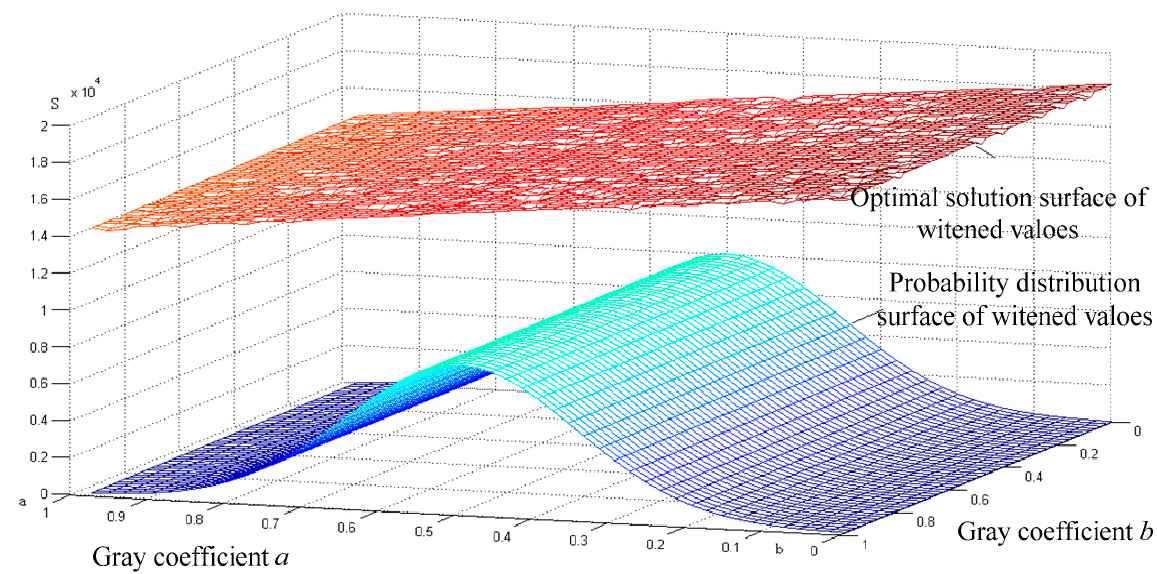
Figure 3. Economic operation flowchart for the grey multi-objective linear programming model. The range of corresponding whitening constraint values a and b for the x - and y -axes is [0, 1], µ α = 0.02, and λ ( b h ) = N ( 0.5 0.1 ) , integrating results and the optimal whitened solution are weighted by sum, and the results obtained are shown in Figure 4.